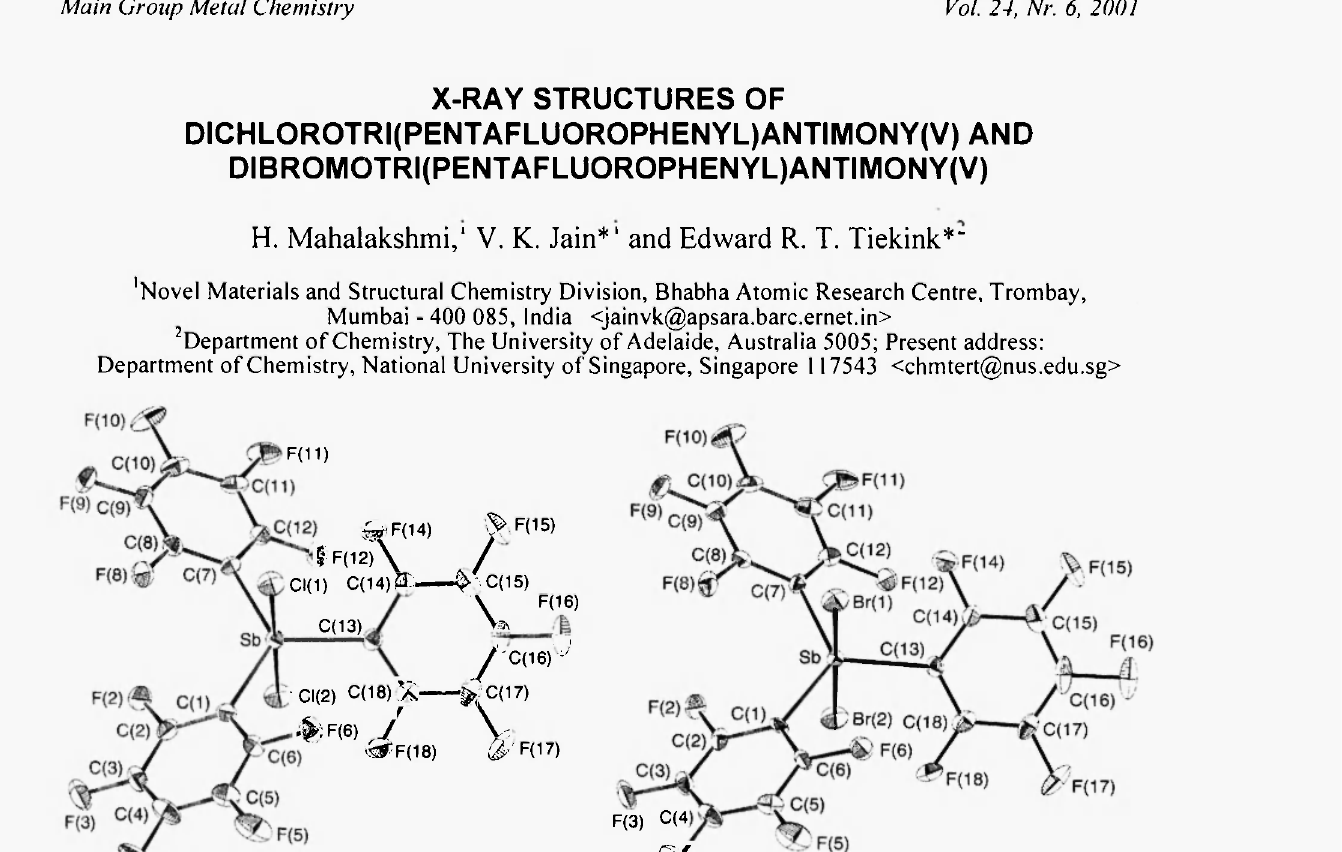
Figure 1. Molecular structures (50 % displacement ellipsoids) of [(C 6 F 5 ) 3 SbCI 2 ] and [(C 6 F 5 ) 3 SbBr2]. Selected bond distances and angles [parameters for the bromo derivative follow in square brackets]: Sb-Cl(l) 2.407(1) [2.563(1)1, Sb-CI(2) 2.409(1) [2.566(1)], Sb-C(l) 2.106(4) [2.108(7)], Sb-C(7) 2.105(4) [2.105(7)], and Sb-C(13) 2.101(4) [2.127(7)] Ä; Cl(l)-Sb-Cl(2) 179.33(4) [179.29(4)], Cl( 1 )-Sb-C(I) 89.6(1)